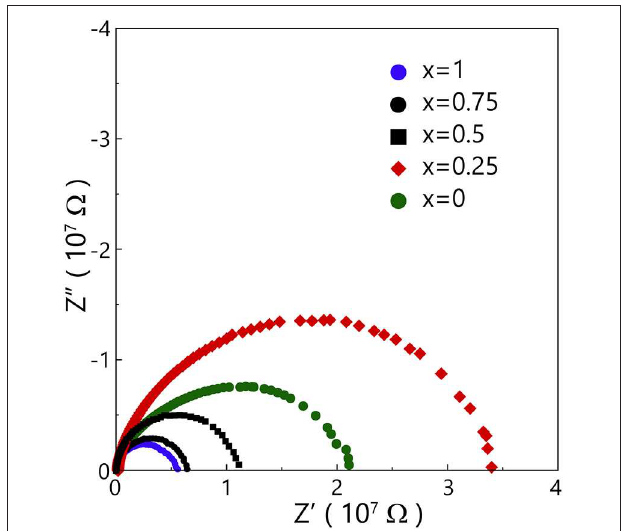
FIGURE 11 | Nyquist plots of heat-treated Na 2 Fe x Ni 1 − x P 2 O 7 pellets at 220 ◦